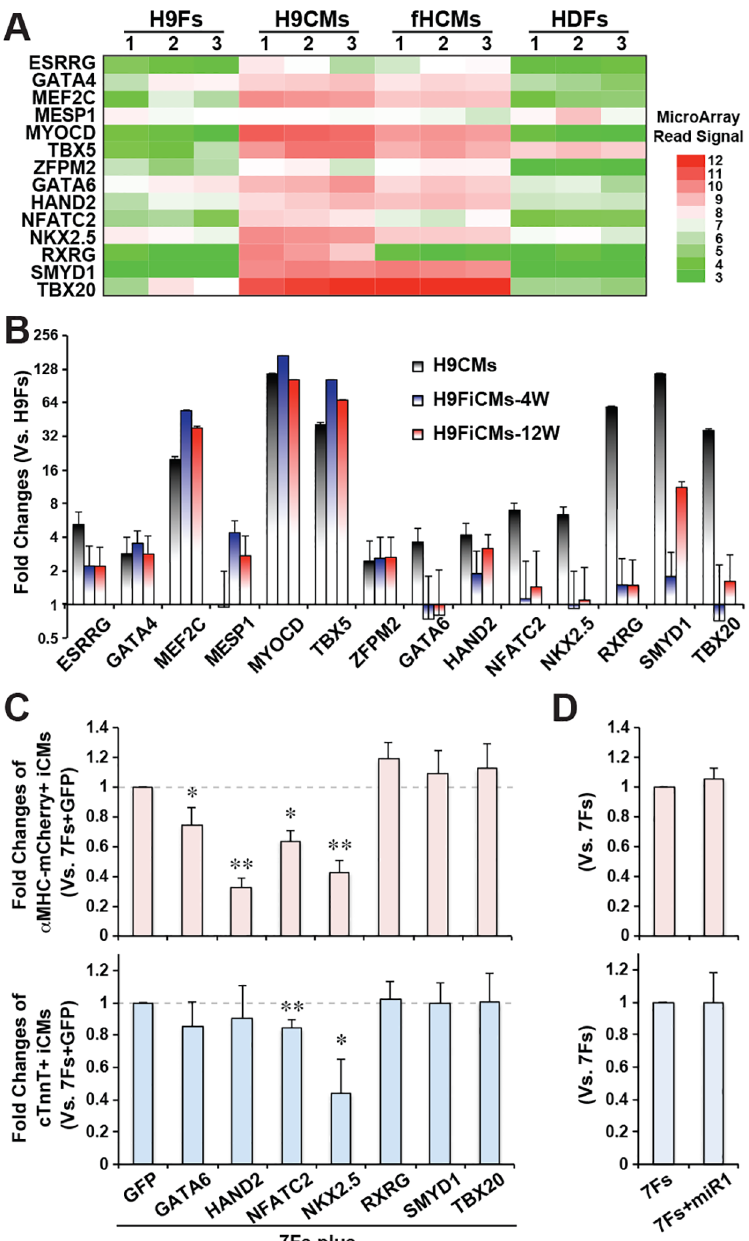
Fig 4. Additional reprogramming factors didn’t increasethe yield of α MHC-mCherry + iCMs. A) Heatmap of gene expressionprofiles for a panel of transcription factors that were expressedat a significantly higherlevel in pooledCMs (H9CMs and fetal humanCMs [fHCMs]) than that in H9Fs and HDFs. B) Fold changes(normalized to H9Fs) of cardiactranscriptionfactors activated in pooledhumaniCMs reprogrammed by 7 factors (7Fs) of GMTEMMZ for 4 weeks (H9FiCMs-4W) and 12 weeks (H9FiCMs-12W). C-D) The effect of addingone extra transcription factor (C) or microRNA-1 (D) on the inductionof α MHC-mCherry + (upper panel, n = 6) or cardiac troponinT (cTnT + , lower panel, n = 4) iCMs reprogrammed by 7Fs. * p < 0.05, ** p < 0.01 comparedto the control group of 7Fs+GFP.